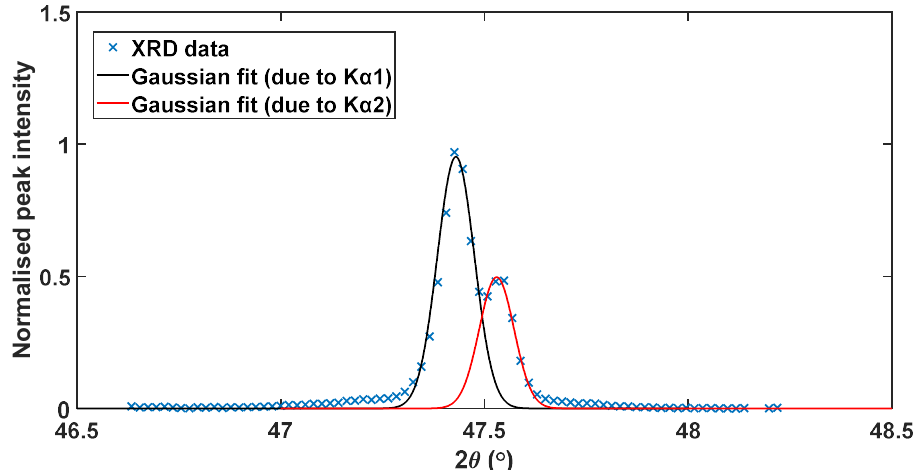
Figure 9. A typical measured XRD data, with the Kα1 and Kα2 deconvoluted peaks using a Gaussian function of ( 101(cid:3364)1 ) reflection.